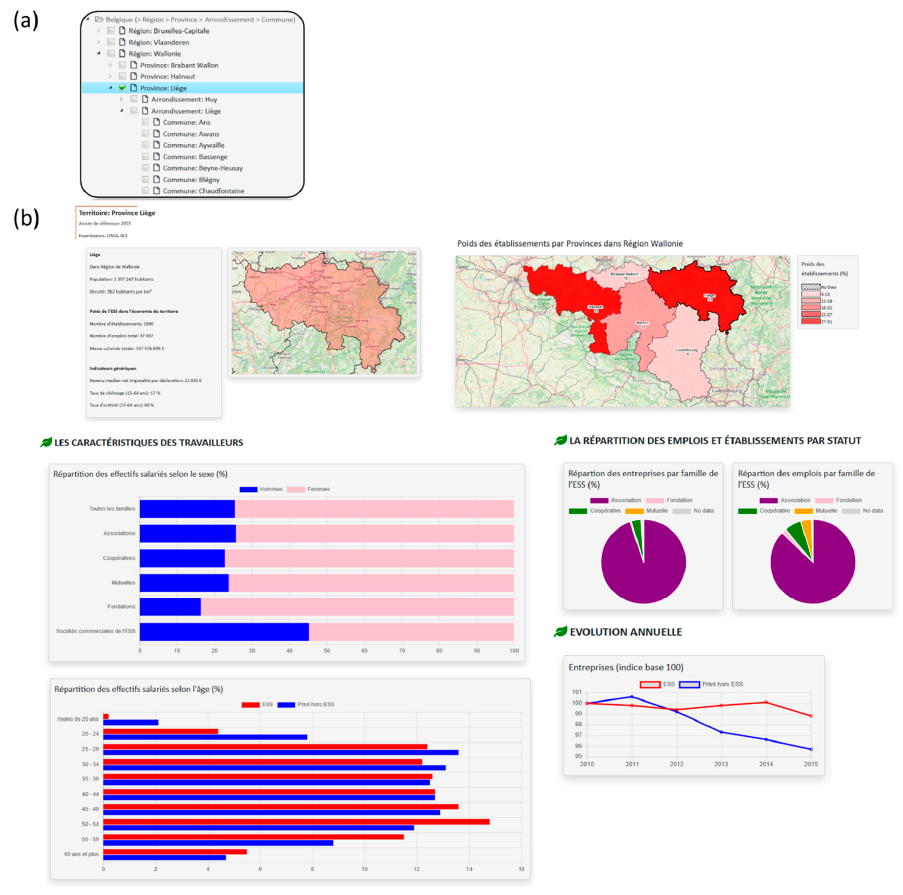
Figure 19. Racines reporting module: ( a )—the tree menu for the selection of a geographic entity, ( b )—the report about the selected entity.